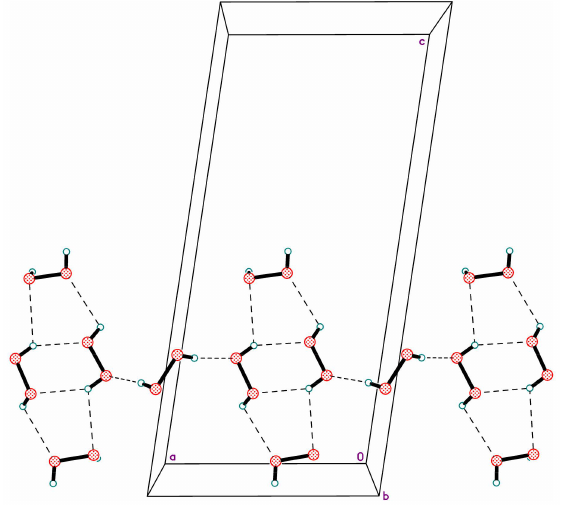
Figure 2. Infinite H-bonded peroxide chains in the structure I . Minor parts of disorder are not shown. Hydrogen bonds are indicated to be dashed lines.